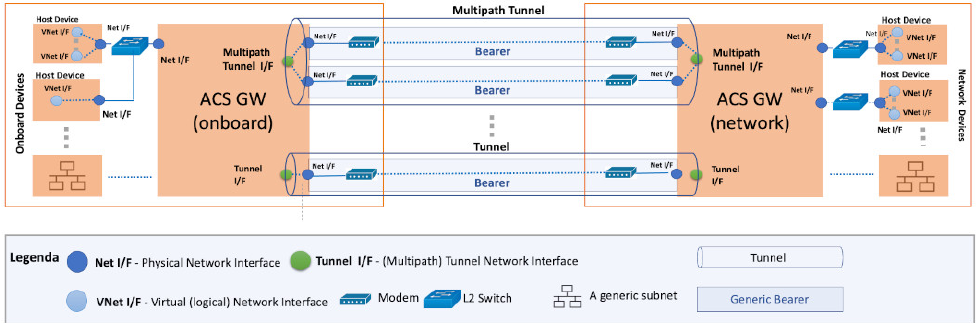
Figure 4. ACS Model Scheme for